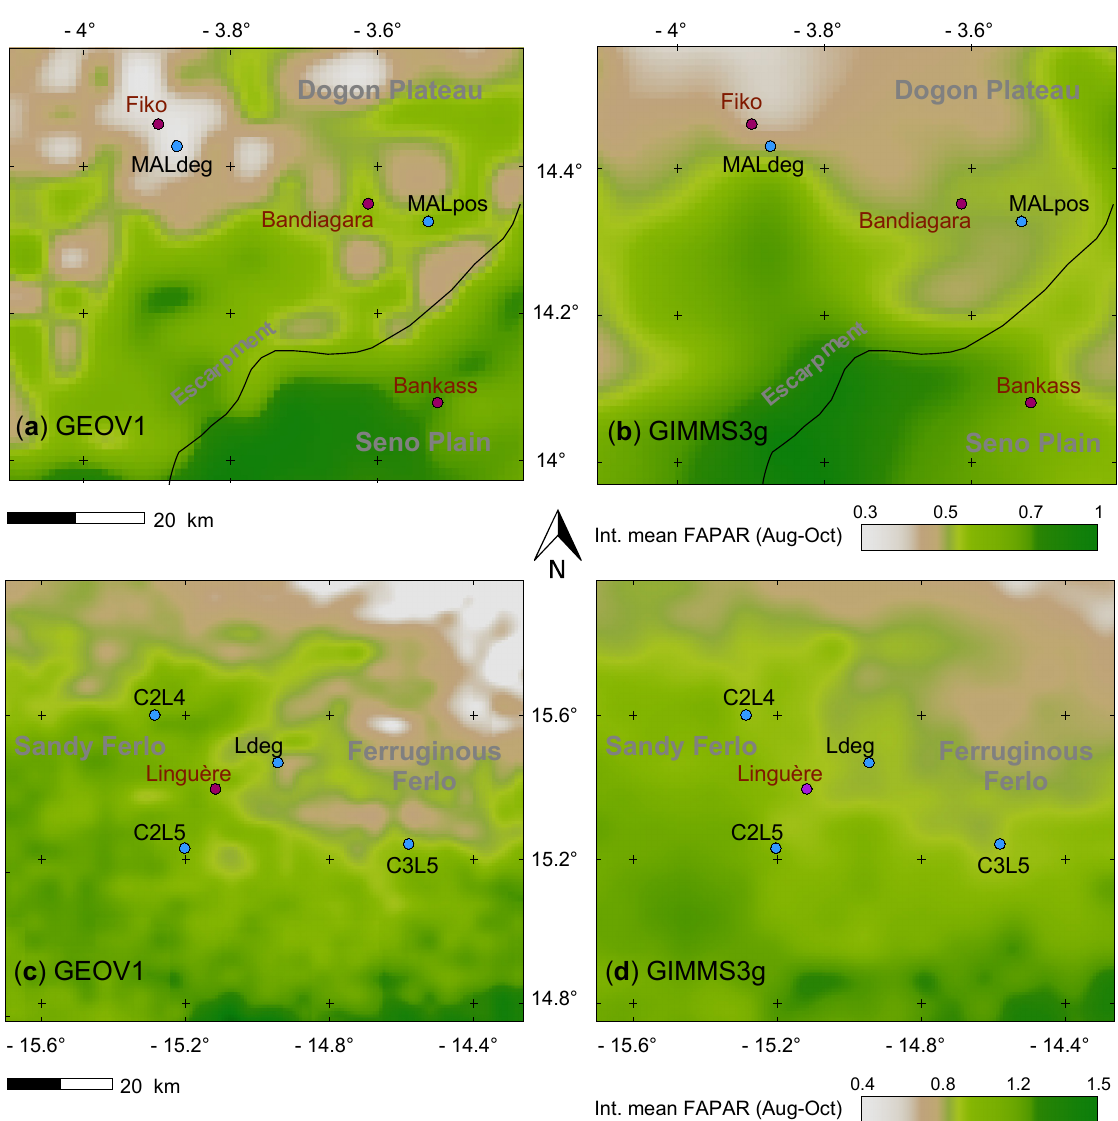
Figure 2. Accumulated FAPAR for mean rainy season (August-October) of GEOV1 FAPAR (left) and GIMMS3g FAPAR (right) from 1982 to 2010. Banidgara ( a , b ) and Lingu`ere ( c , d ) regions both show a good agreement between the two datasets with more details in GEOV1. Sandy areas can be distinguished from lateritic sections (Dogon Plateau in Mali and ferruginous Ferlo in Senegal). In Mali, the Bandiagara escarpment separates the Dogon Plateau from the Seno Plain around Bankass. All rasters were interpolated to a spatial resolution of 1 km by a bicubic interpolation method for a better visual inspection and interpretation. No quantitative information is lost nor added by applying this method.